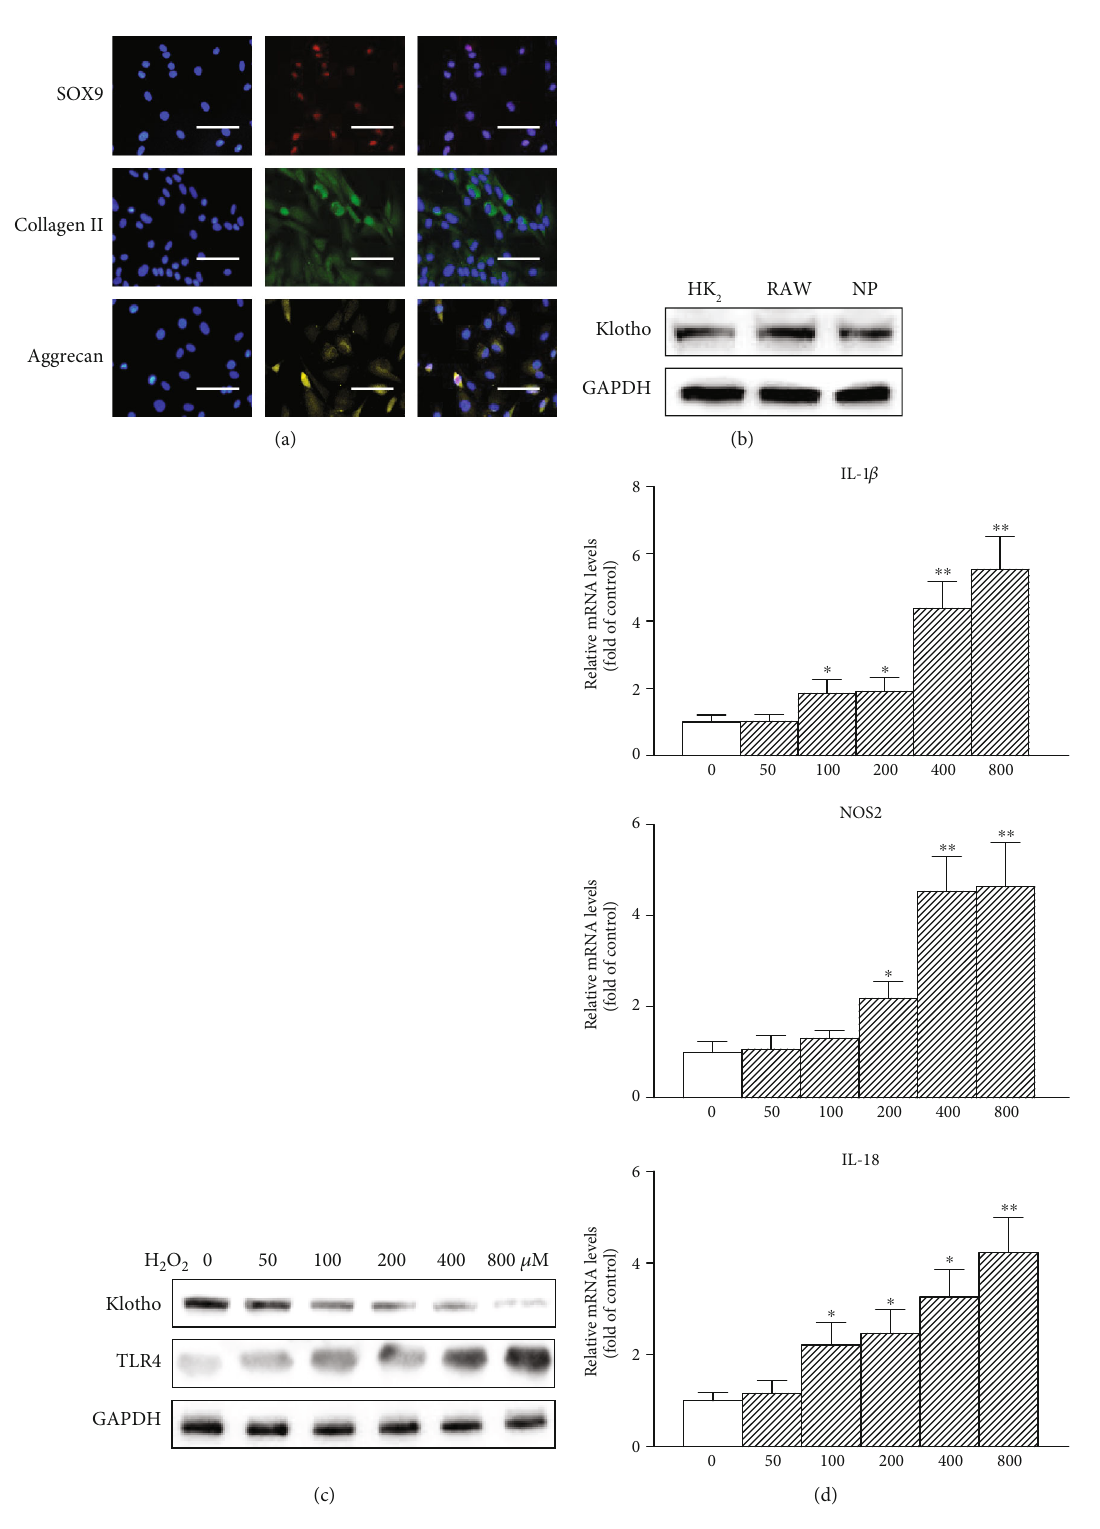
Figure 2: DecreasedKlothoexpressioninNPcellstreatedwithH con fi rmthepurityofinvitroprimaryNPcellsculture,onerepresentativeexperimentofsixwasshown.Scalebar,20 μ m(originalmagni fi cation, × 40). (b) Klotho protein expression was tested from human renal tubule epithelium HK2 cells, mouse macrophage RAW264.7 (RAW), and NP cells by Western blotting. (c) NP cells were treated with increasing amounts of H Klotho and TLR4 protein levels were assayed by Western blotting. (d) NP cells were treated with increasing amounts of H 200, 400, and 800 μ M) for 6h, and then IL-1 β , NOS2, and IL-18 mRNAs were assayed by qRT-PCR. GAPDH served as an internal control. The results were presented as mean ± SD of three independently performed experiments. ∗ P < 0 : 05 , ∗∗ P < 0 : 01 vs.